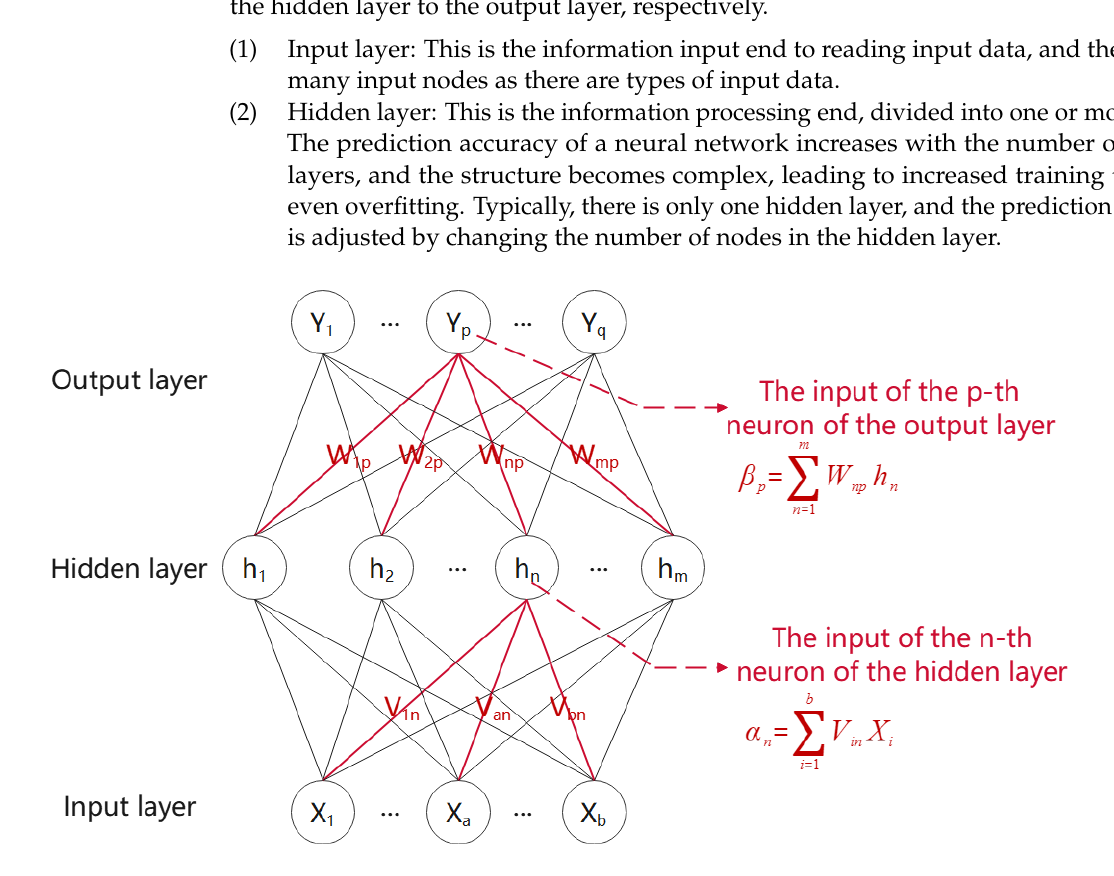
Figure 4. Topological structure of neurons.